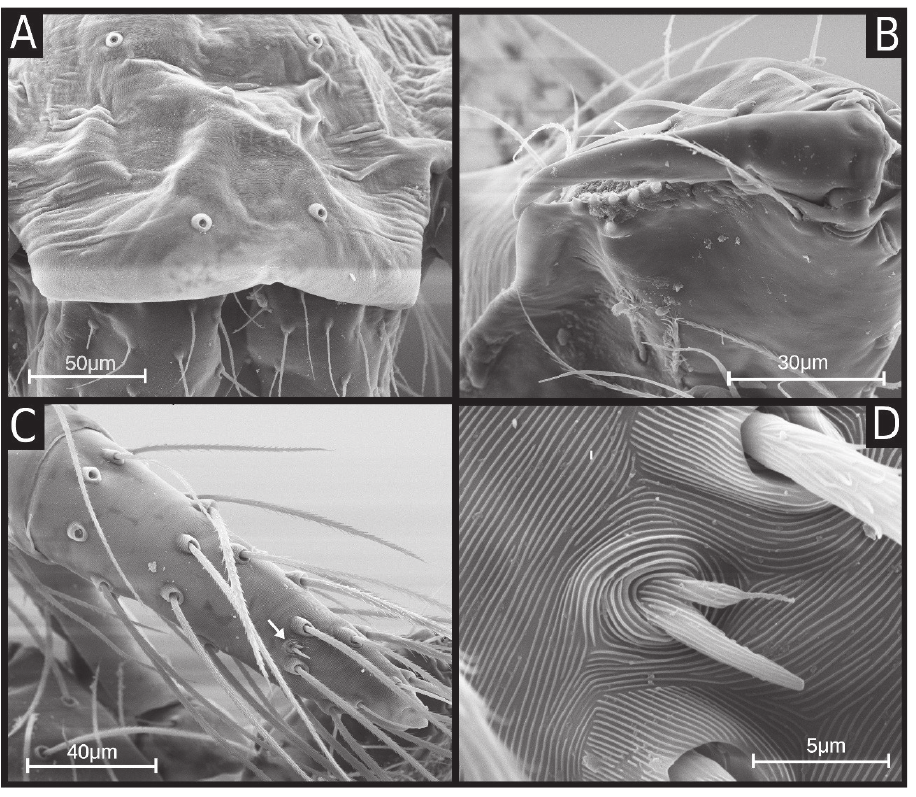
Figure 4. SEM images of Ochyrocera dorinha sp. nov., female (IBSP 198873) A carapace, anterior view B chelicerae, frontal view C pedipalp, distal, prolateral view D same, tarsal organ,